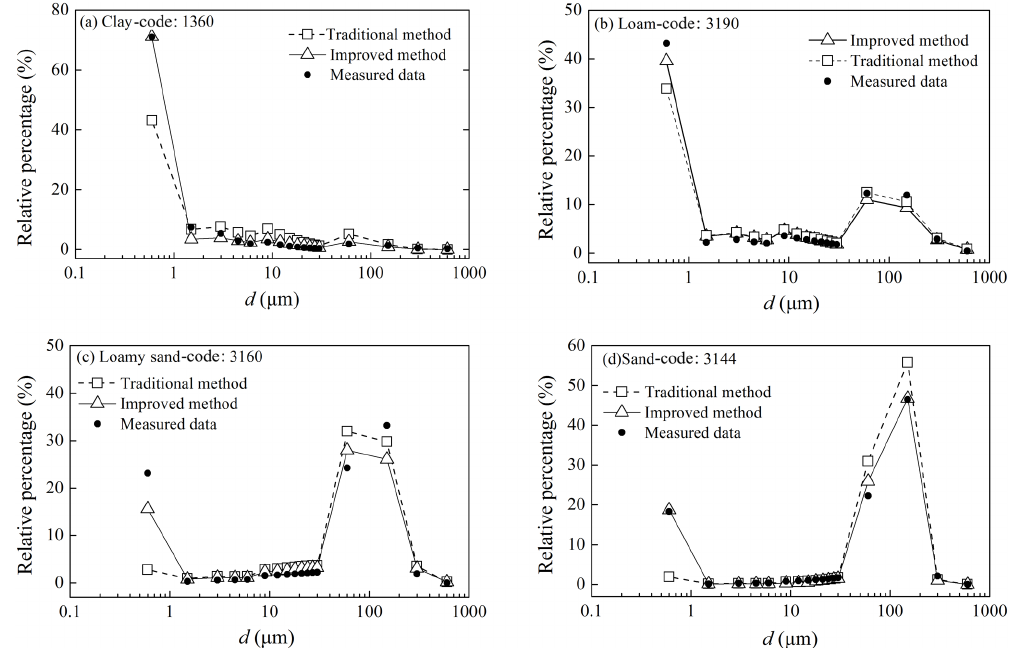
Figure 6. The measured and predicted pore volume fraction curves using the improved method and traditional method for clay (code: 1360), loam (code: 3190), loamy sand (code: 3160) and sand (code: 3144).